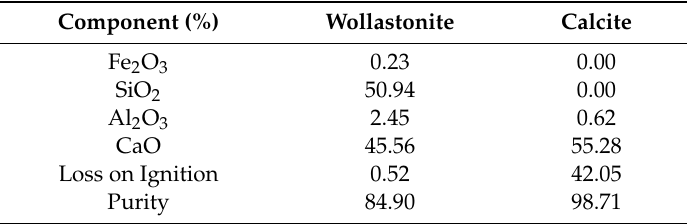
Table 1. Mineralogical composition of wollastonite and calcite